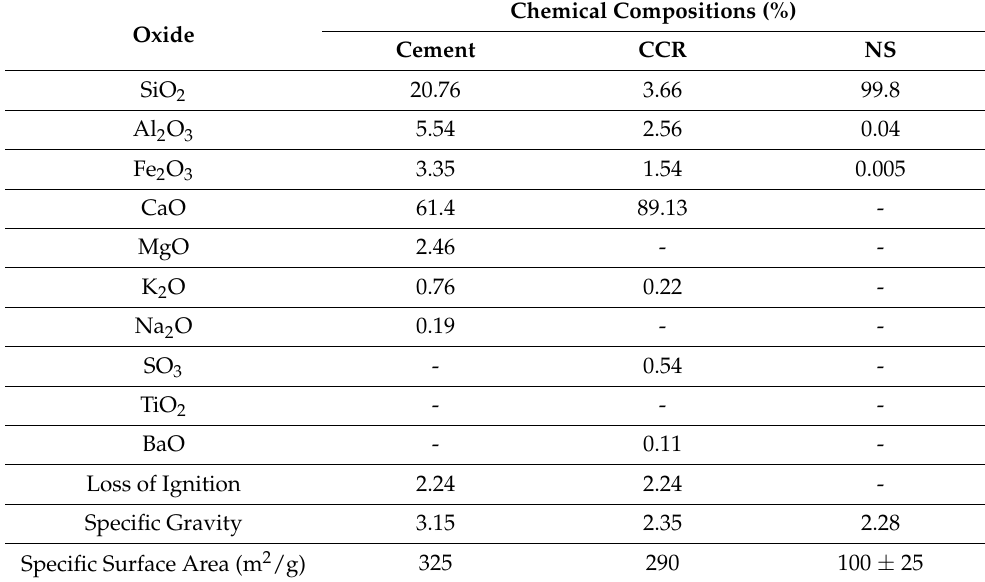
Table 1. Chemical properties of